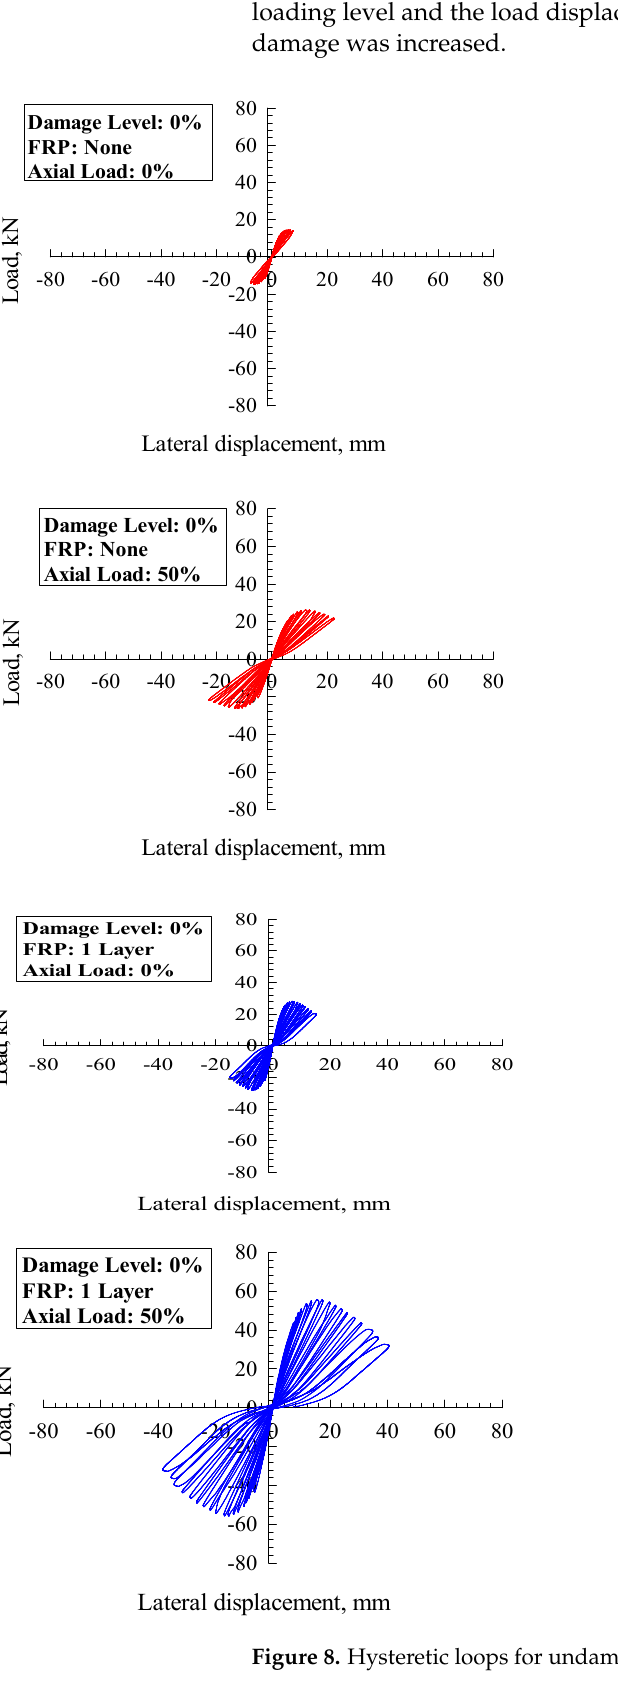
Figure 8. Hysteretic loops for undamaged joints.